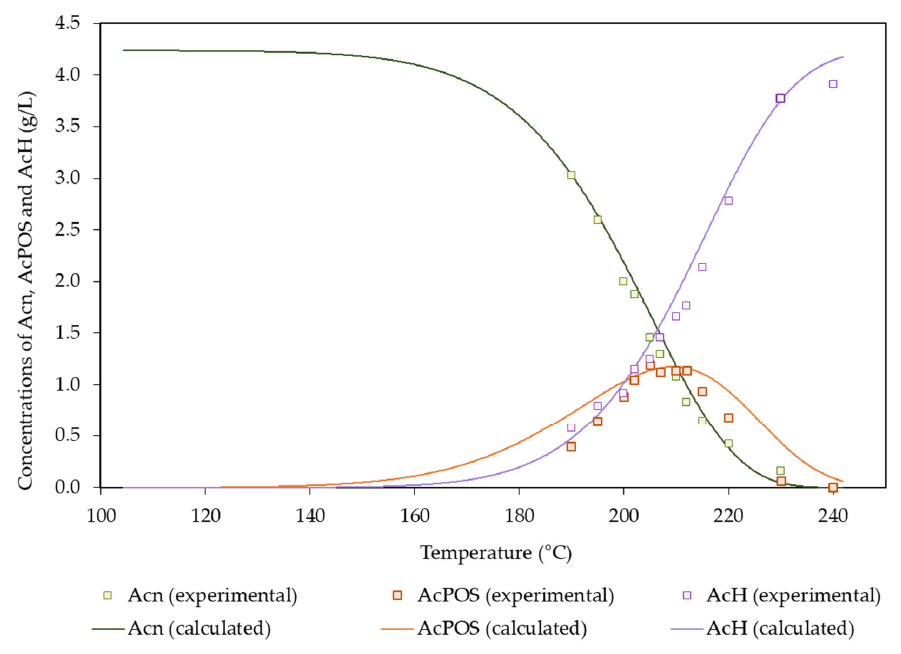
Figure 6. Experimental and calculated concentration profiles determined for acetyl groups and acetic acid.